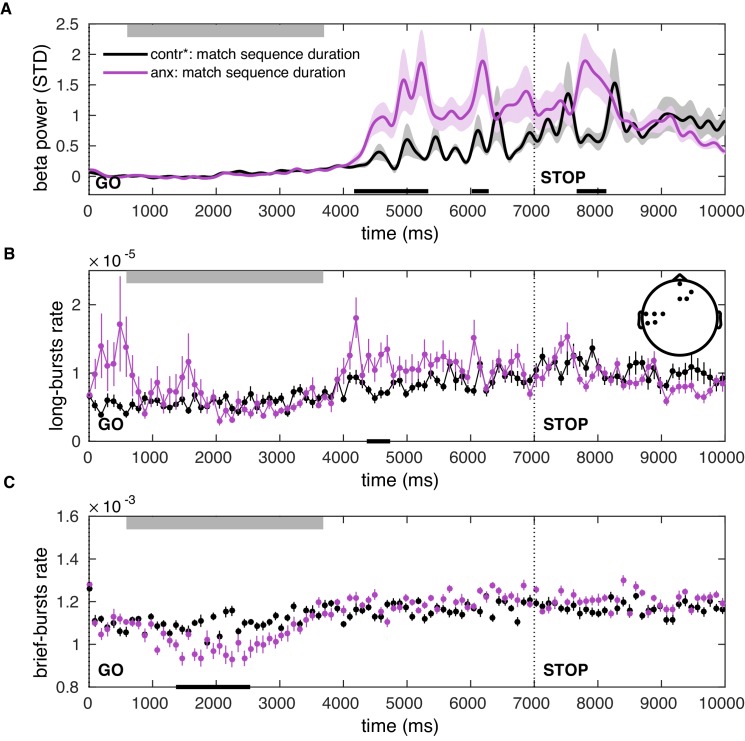
Post-movement increases in the beta-band amplitude and burst rate can be explained by state anxiety after matching participants on the sequence duration.(A–C) Same as Figure 8—figure supplement 1 but after matching participants in the total duration of the sequence.